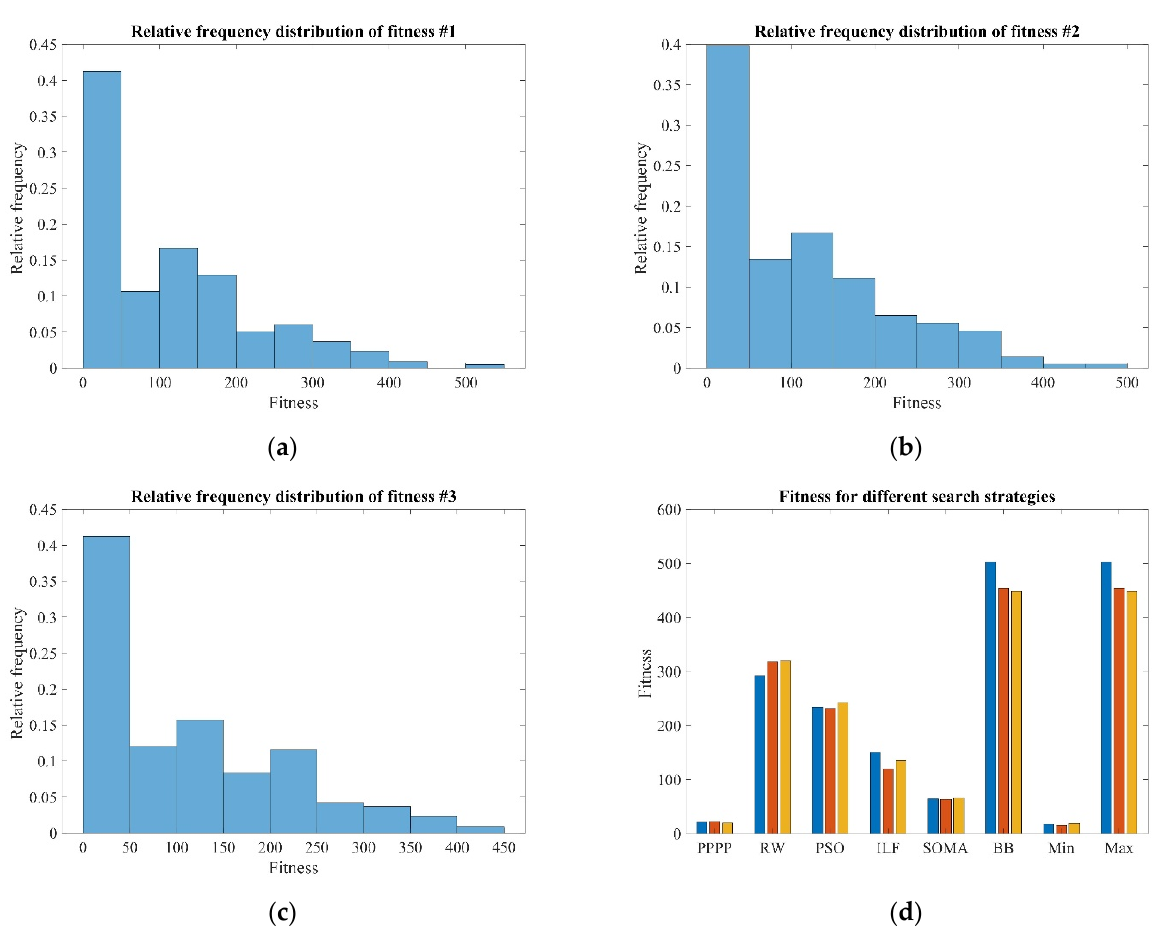
Figure 26. ( a – c ) Histograms of the relative distribution of fitness values of the different combinations of search strategies; ( d ) fitness for proposed search strategies and fitness of best and worst combination. Table 5. Overview of the best combined search strategies from the three repetitions.